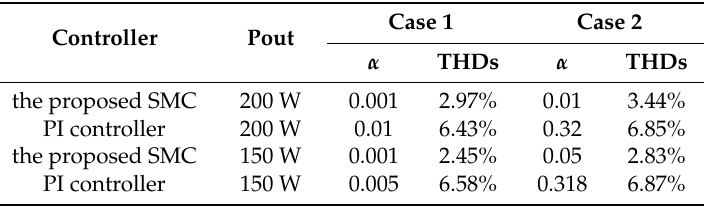
Table 4. Simulink